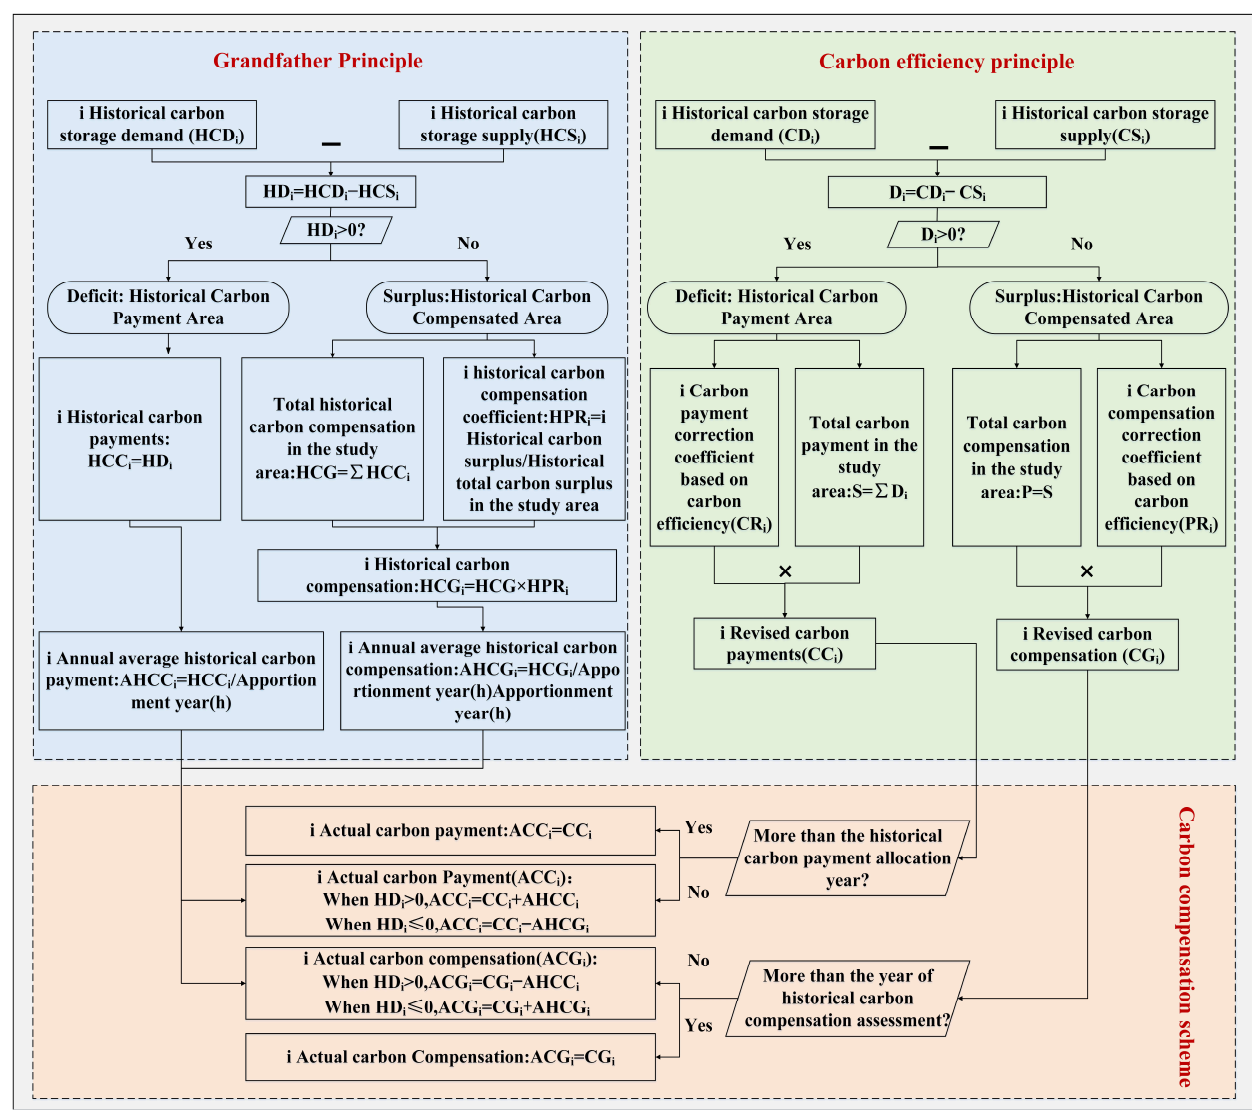
Figure 3. Carbon compensation scheme consisting of the grandfather principle and the carbon efficiency principle. efficiency